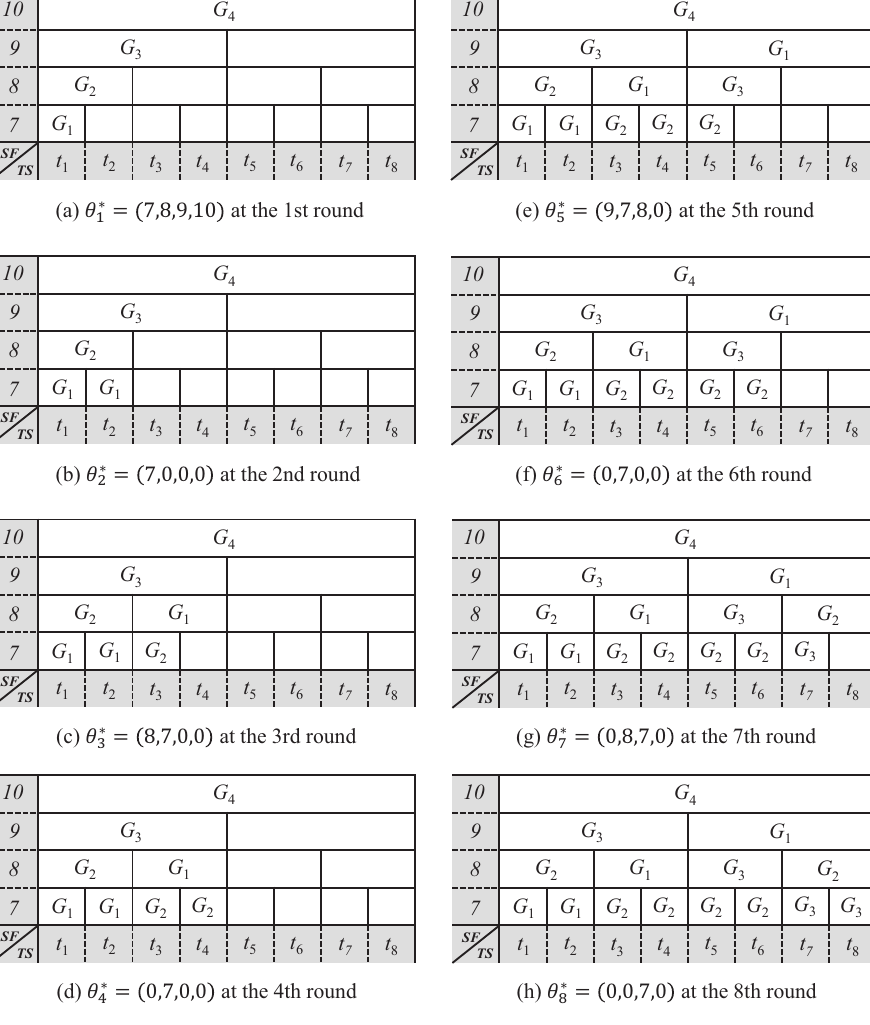
Figure 5. Procedures of allocation in SF and timeslot for GACK transmission in downlink transmis- sion period